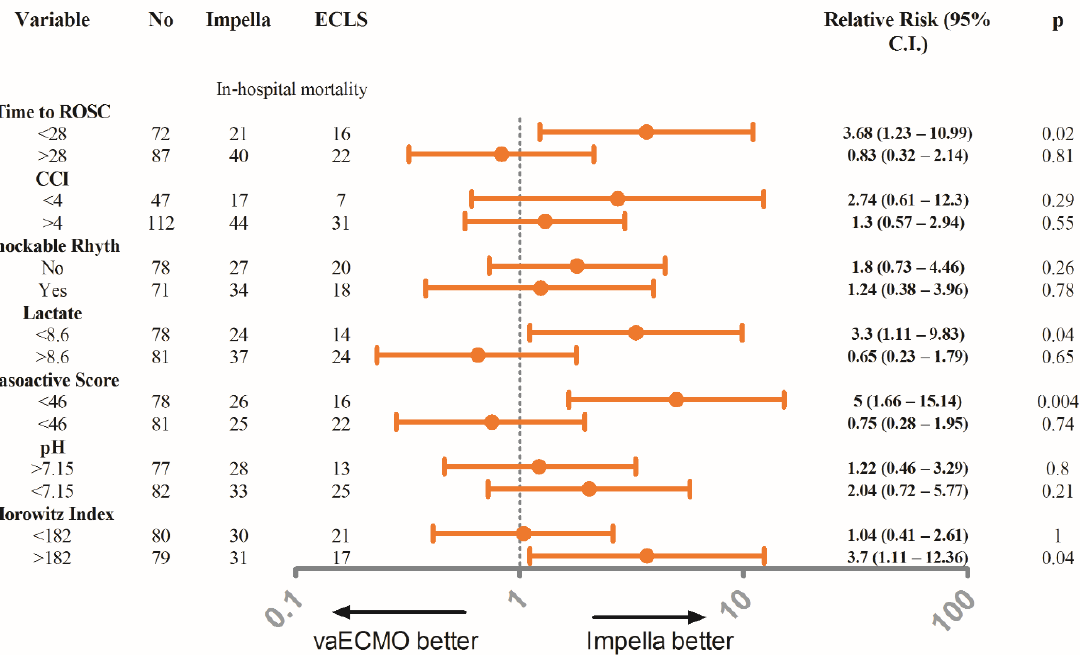
Figure 2. Forest plot displaying the relative risk of different tested subgroups for the primary endpoint hospital mortality in the overall cohort.